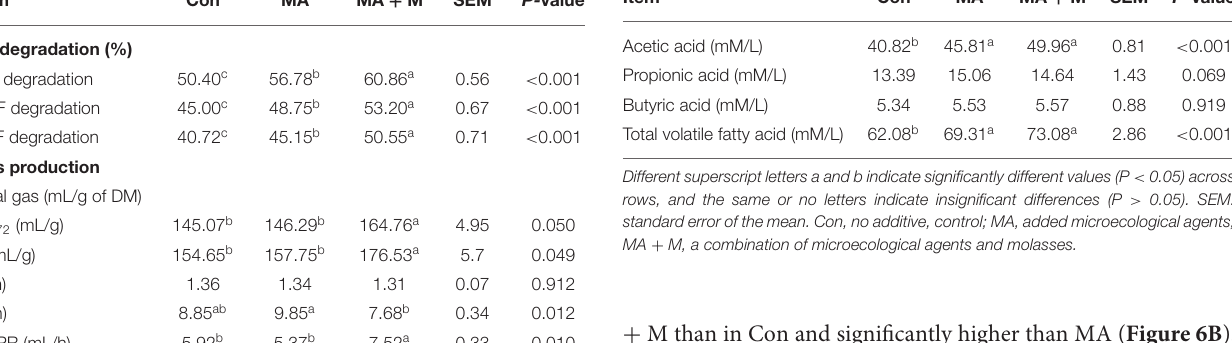
TABLE 2 | Effects of MA pretreatment on the biodegradation and parameters of gas production after 72h of in vitro ruminal incubation of rice straw.